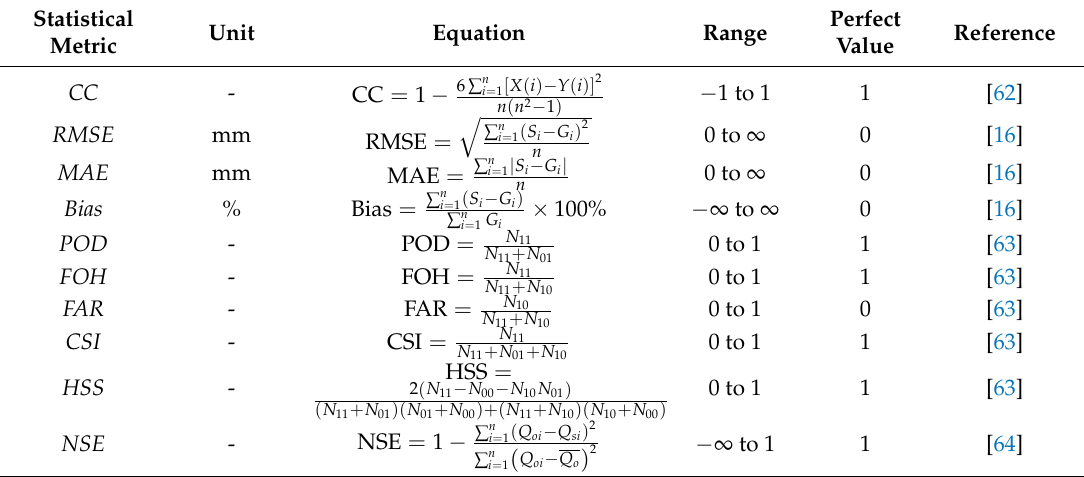
Table 1. Indices used to evaluate the performance of satellite precipitation estimates. CC :